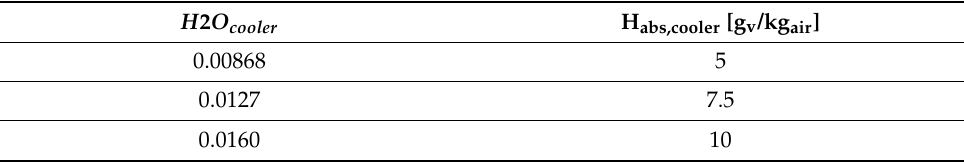
Table 5. Values of H 2 O cooler adopted in Equation (13) for the validation of the procedure and the corresponding H abs,cooler values in the cooled gases entering the CO 2